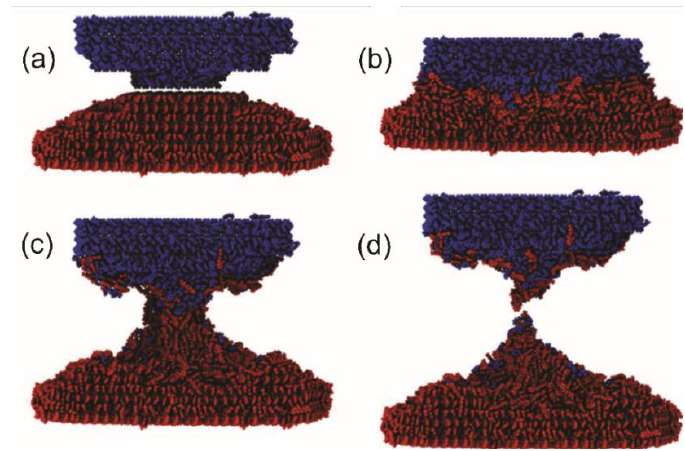
Figure 4. Simulated indentation between fragments of meloxicam molecules (red) and aspirin molecules (blue) at four different stages. The indentation velocity was 4 m/s. Molecules in the three upper layers of the aspirin cluster and in the three bottom layers of the meloxicam slab (not shown) were fixed during the simulation. ( a ) Initial configuration. ( b ) The point of maximum indentation. ( c ) Intermediate stage during retraction before the connective neck (center) breaks. ( d ) The resulting configuration after one indentation event. Figure adapted with permission from The Royal Society of Chemistry, from “Insights into Mechanochemical Reactions at the Molecular Level: Simulated Indentations of Aspirin and Meloxicam Crystals,” by M. Ferguson, M.S. Moyano, G. A. Tribello,